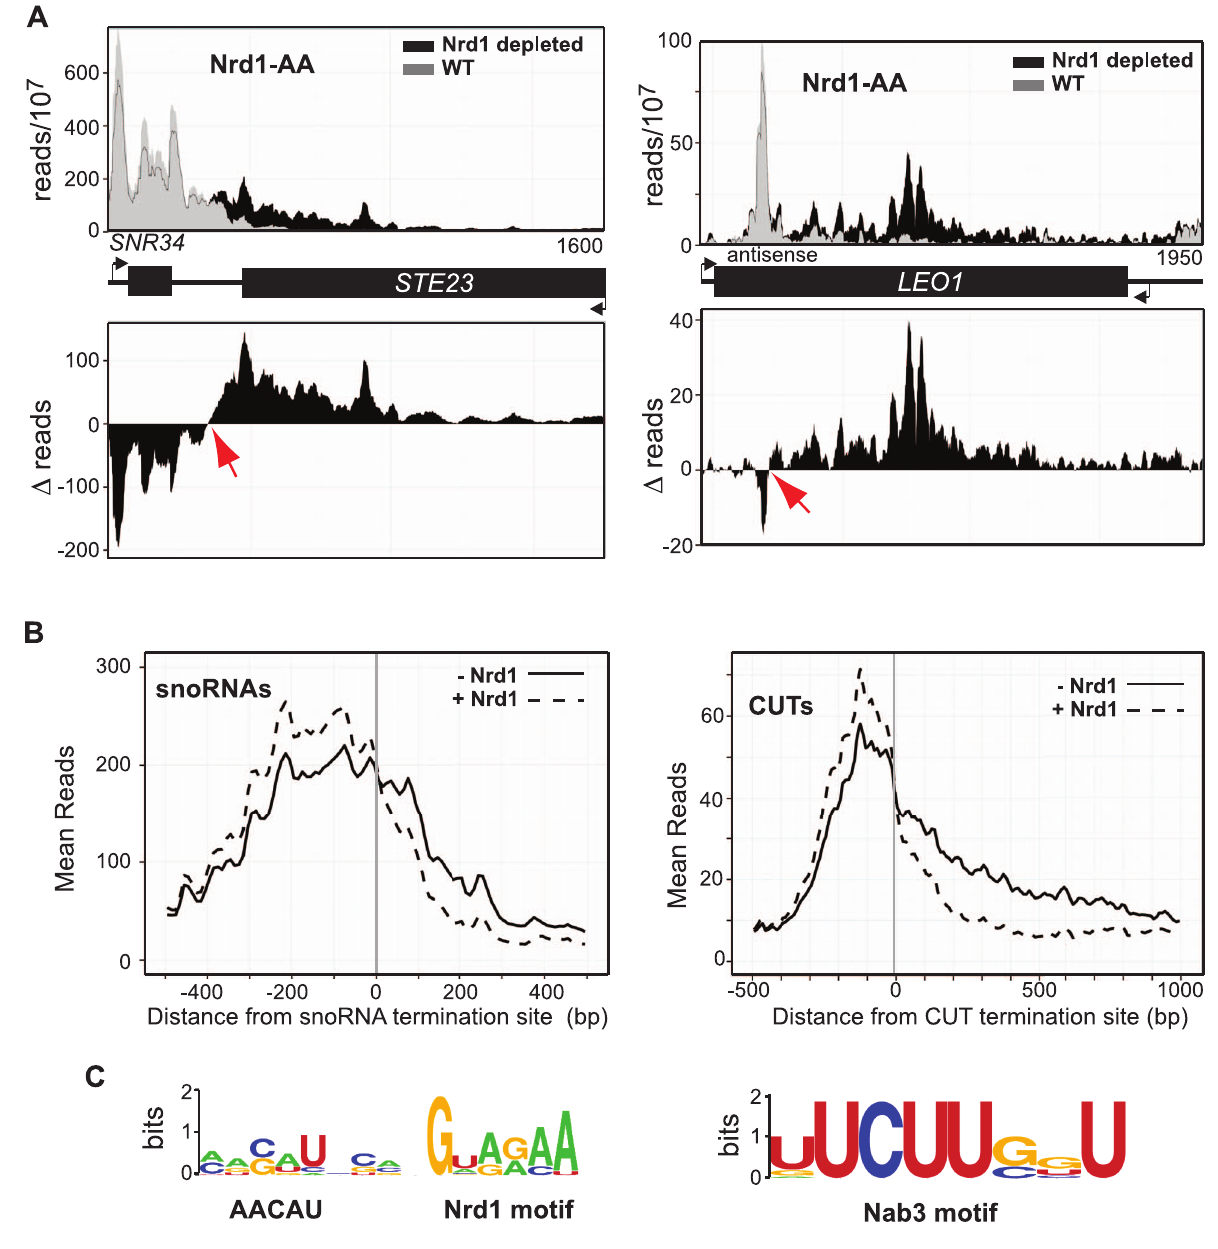
Figure 3. Mapping Nrd1-dependent terminators. A. Histograms representing of normalized reads for NRD1-FRB with Nrd1 (grey) and without Nrd1 (black) at the given genomic locations. The difference between WT and Nrd1-depleted at every nucleotide is represented as a histogram below each graph. B. Mean reads every 10 bp for 49 snoRNA termination sites showing the highest level of readthrough and 144 CUT termination sites with Nrd1 (dotted) and without Nrd1 (solid). C. Most abundant Nrd1 motif and the most abundant Nab3 motif in the 150 nt 5 9 of the snoRNA and CUT terminators, respectively. MEME input parameters were any number of motifs of length 4–15 nt. Results are presented using WebLogo [92].